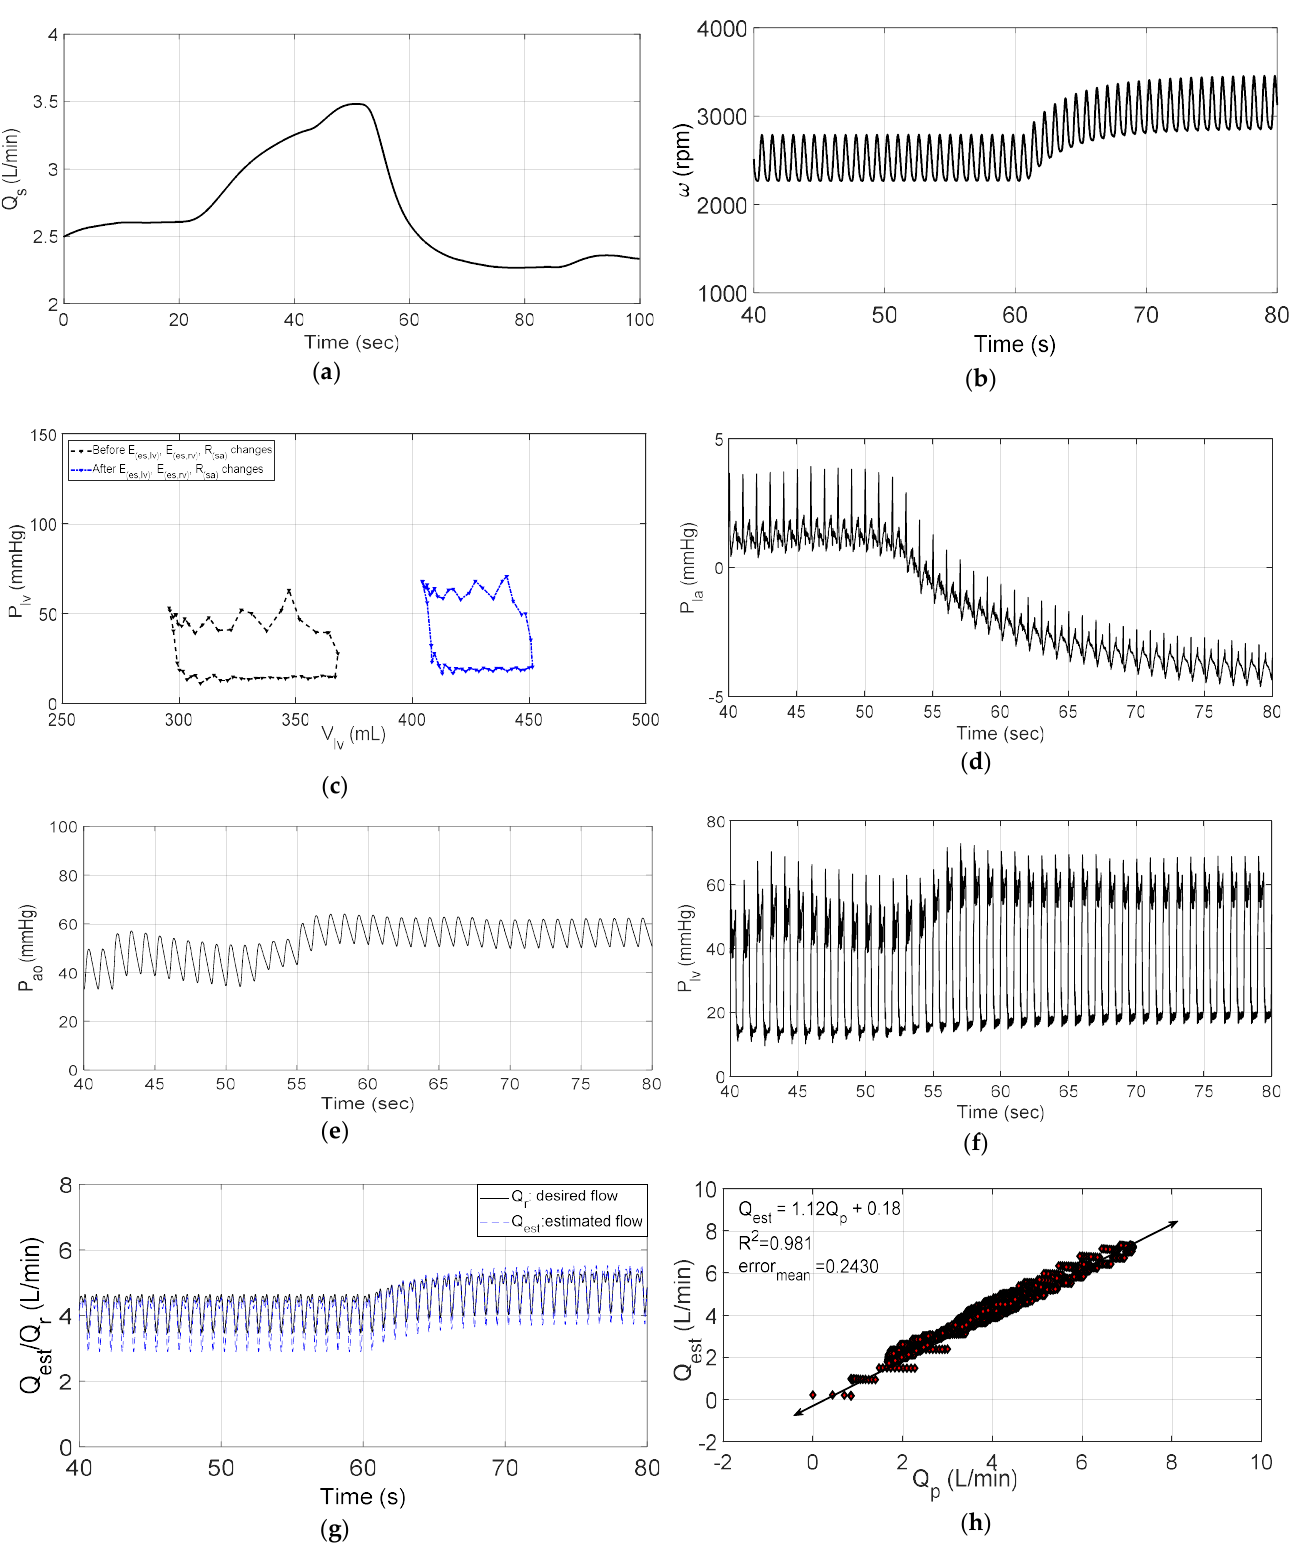
Figure 7. Results in exercise test; ( a ) systematic flow ( Q s ); ( b ) IRBP speed ( ω ( t ) ); ( c ) stroke volume (SV); ( d ) left atrium pressure ( P la ); ( e ) aortic pressure ( P ao ); ( f ) left ventricle pressure ( P lv ), ( g ) estimated flow ( ˆ Q est ) vs. desired reference flow ( Q r ); ( h ) correlation between estimated flow ( ˆ Q est ) and actual flow ( Q p